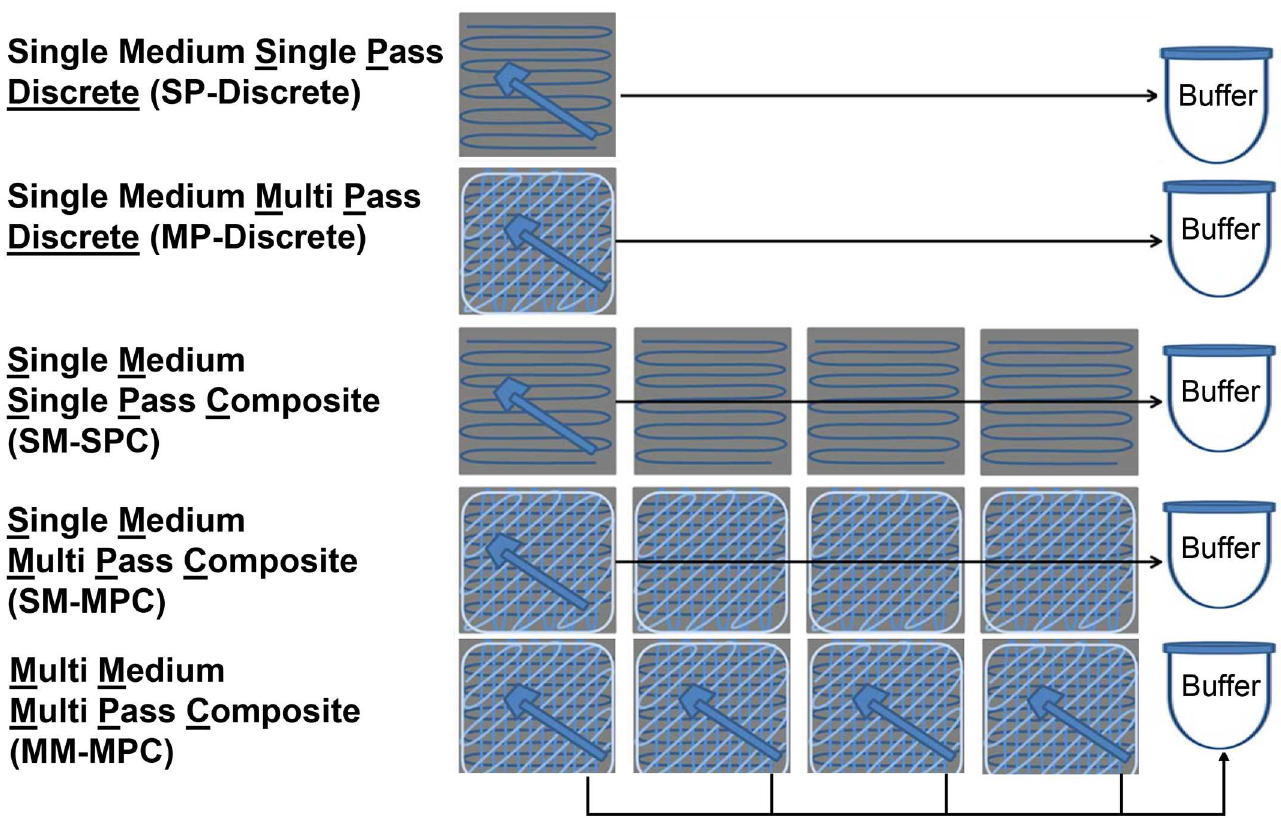
Fig 1. Pictorial overview of the sampling methods used in the study. Single medium single-pass discrete (SP-Discrete); singlemedium multi- pass discrete (MP-Discrete); single medium, single-pass composite (SM-SPC); single medium, multi-pass composite (SM-MPC); and multi- medium, multi-pass composite (MM-MPC) were used in the study. Buffer; Phosphatebuffered saline containing0.02% Tween 80.